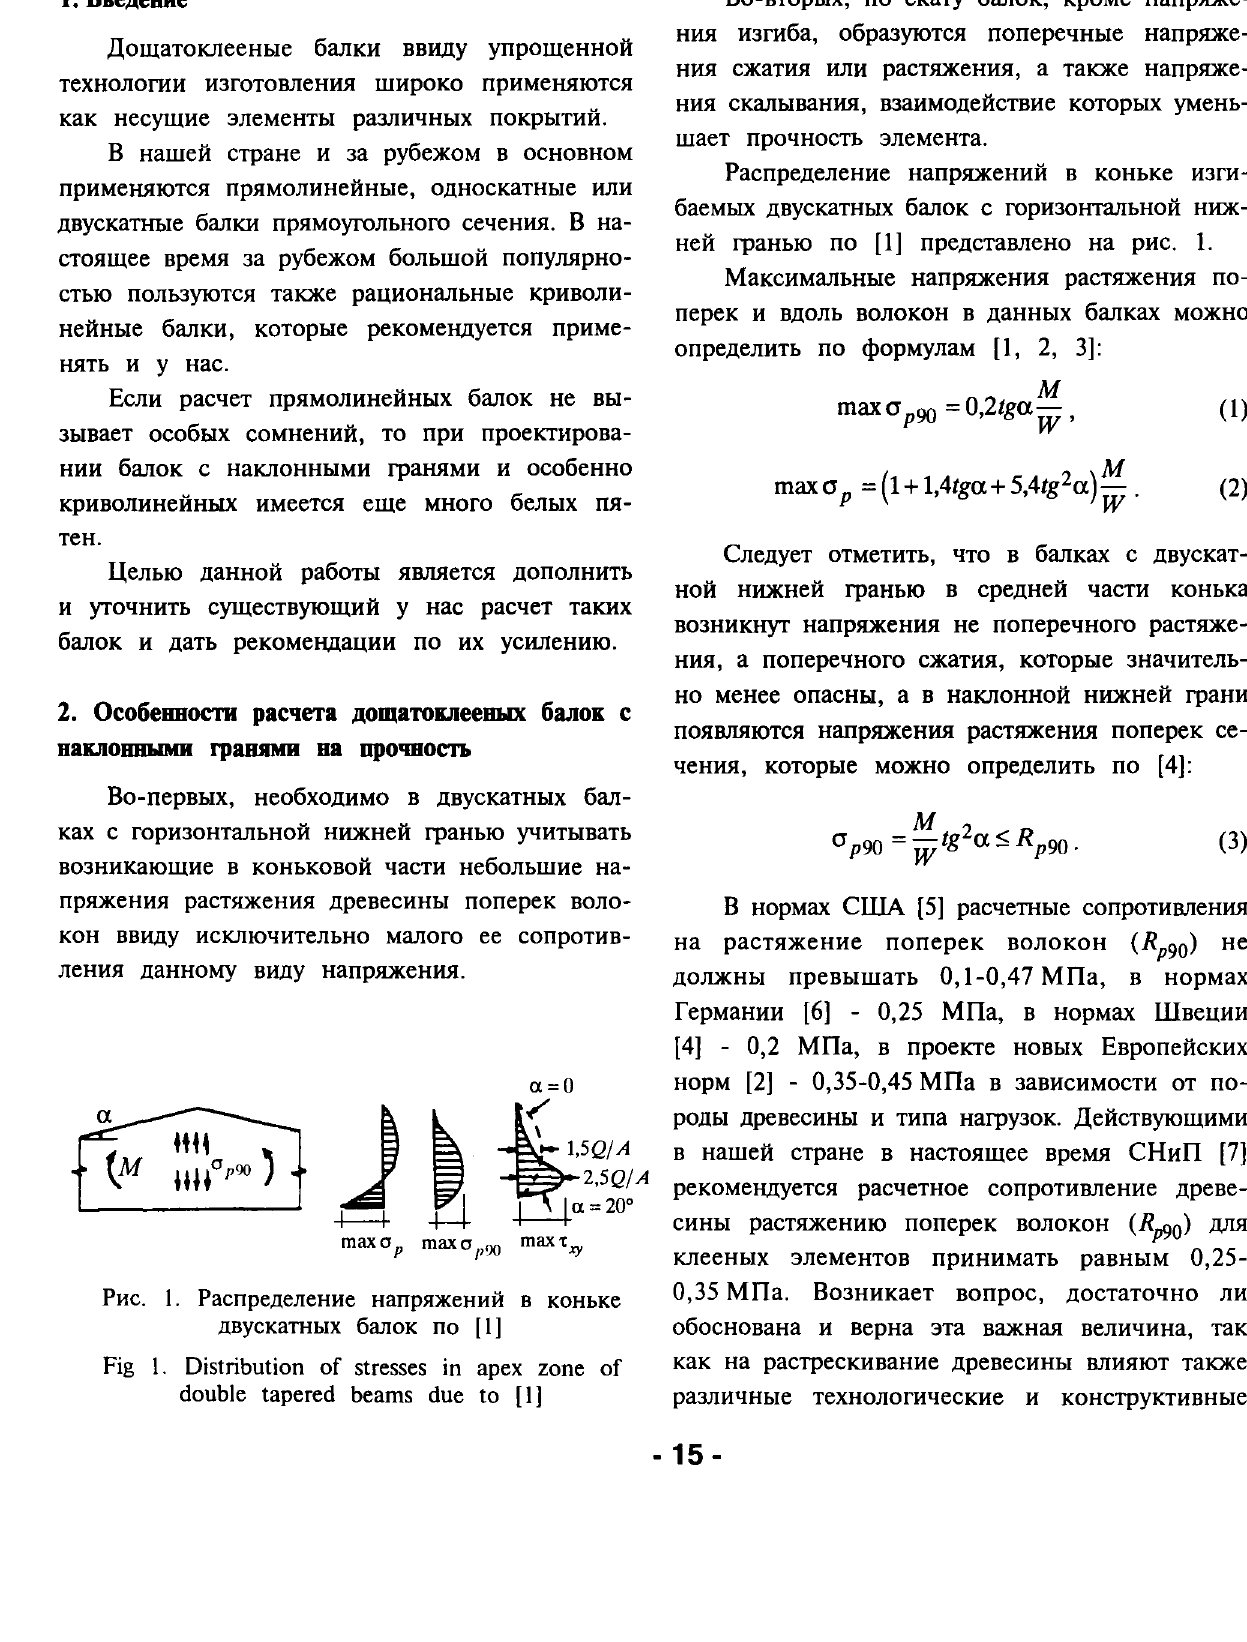
Fig I. Distribution of stresses in apex zone of double tapered beams due to